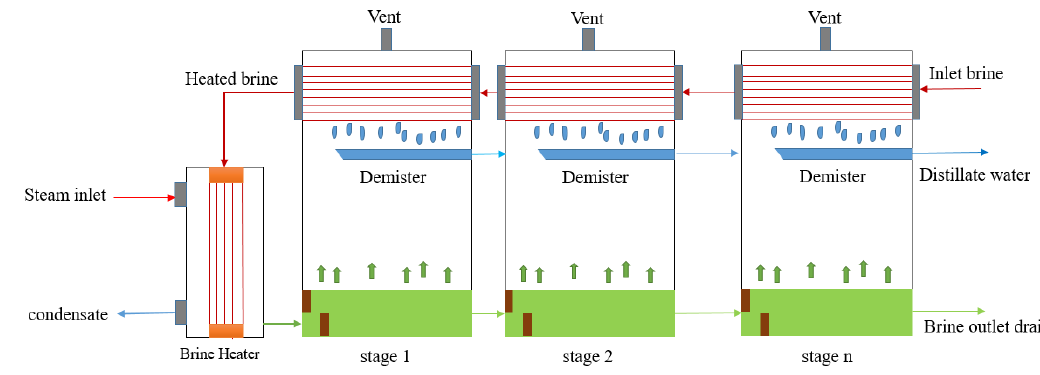
Figure 5. The once-through multi-stage flash process.